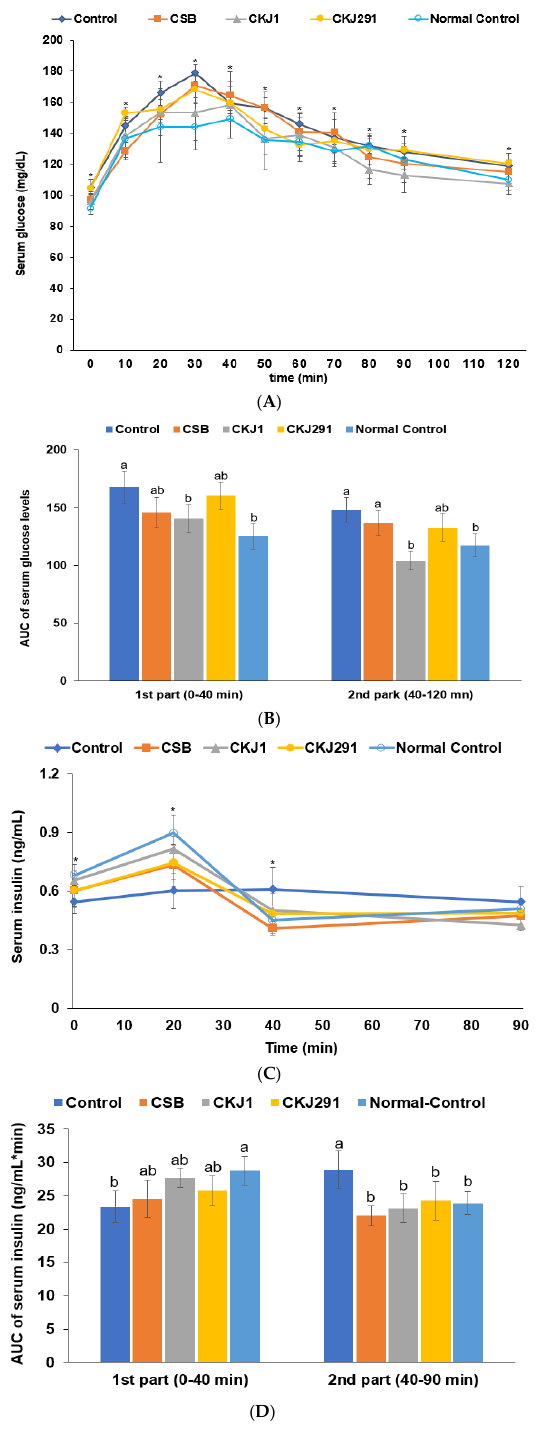
Figure 4. Oral glucose tolerance test (OGTT). Gerbils underwent an OGTT with 2 g glucose/kg body weight after overnight fasting on the 17th day after artery occlusion. The changes of serum glucose levels during 120 min ( A ) and area under the curve (AUC) of serum glucose concentrations in the first part (0–40 min) and the second part (40–120 min) during OGTT ( B ). The changes of serum insulin concentrations during 120 min ( C ) and AUC of serum insulin concentrations ( D ). * Signifi- cantly different among the groups at p < 0.05. Bars and dots represent means ± SD ( n = 10). a,b Means on the bars with different letters were significantly different by Tukey’s test at p < 0.05.